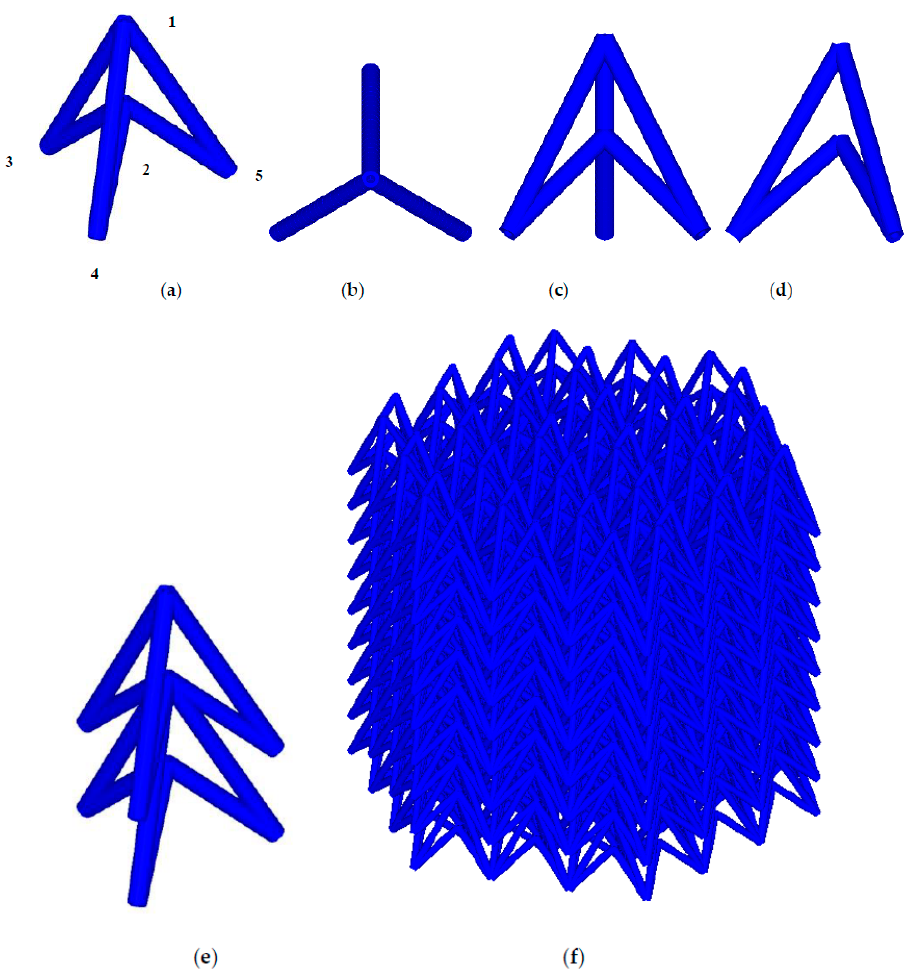
Figure 1. The schematic of Type A lattice in: ( a ) 3D viewpoint; ( b ) top view ( c ) front view; ( d ) left view; and ( e ) an array.